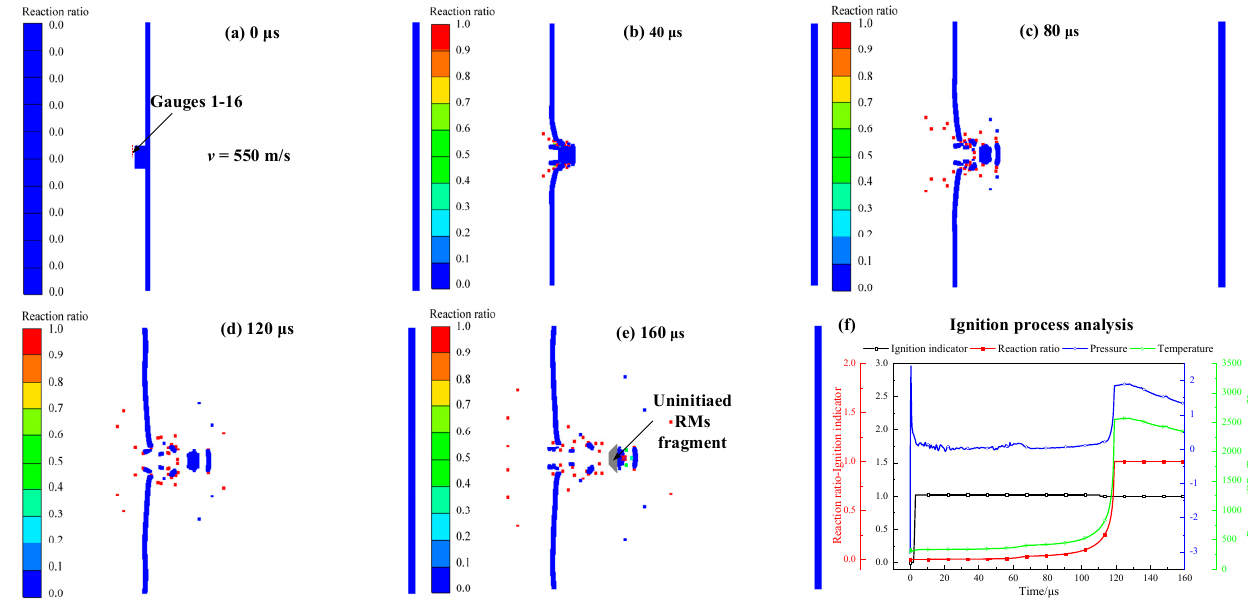
Figure 9. The typical ignition process of RMPs with a velocity of 550